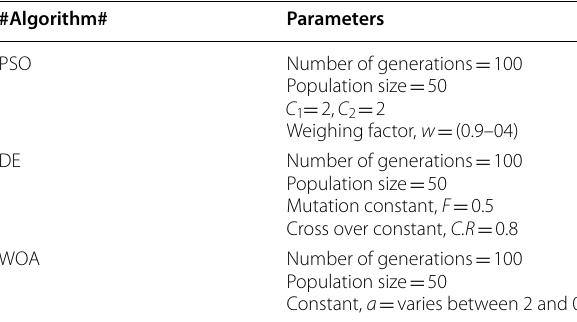
Table 3 Design parameters of optimization